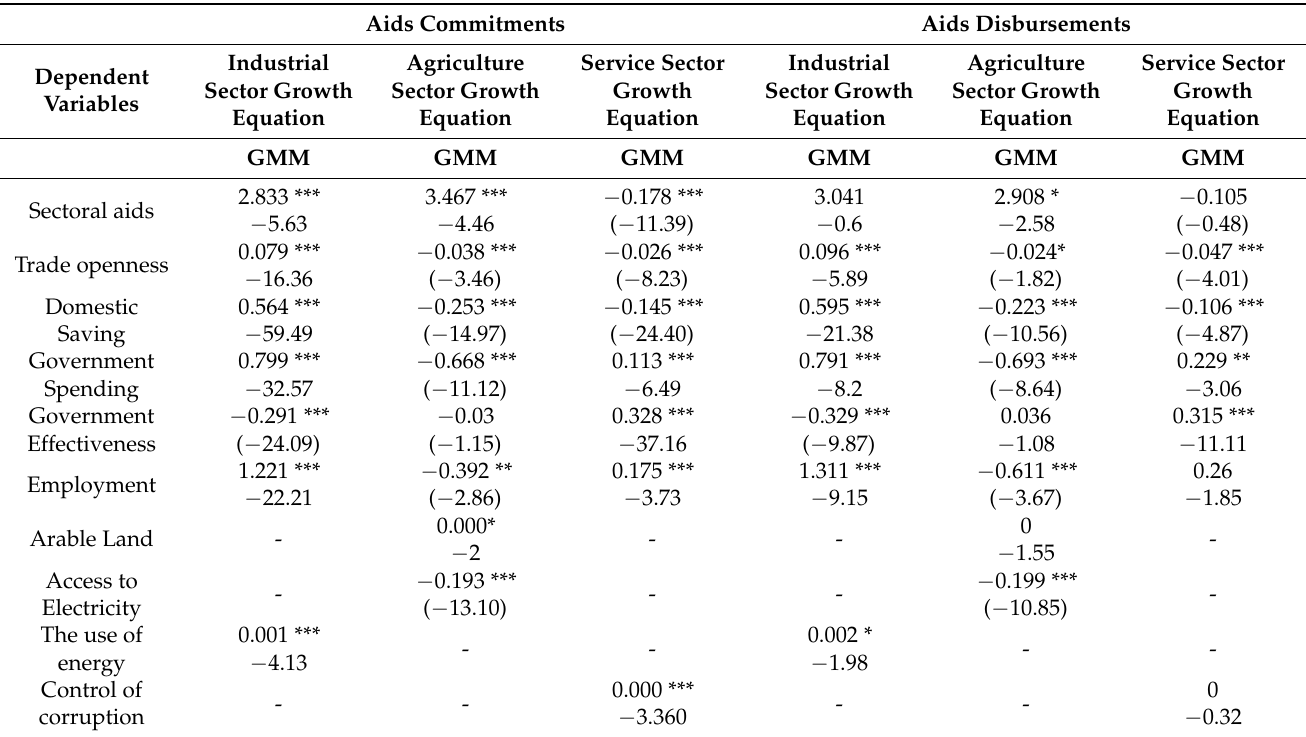
Table A10. Robustness Check with